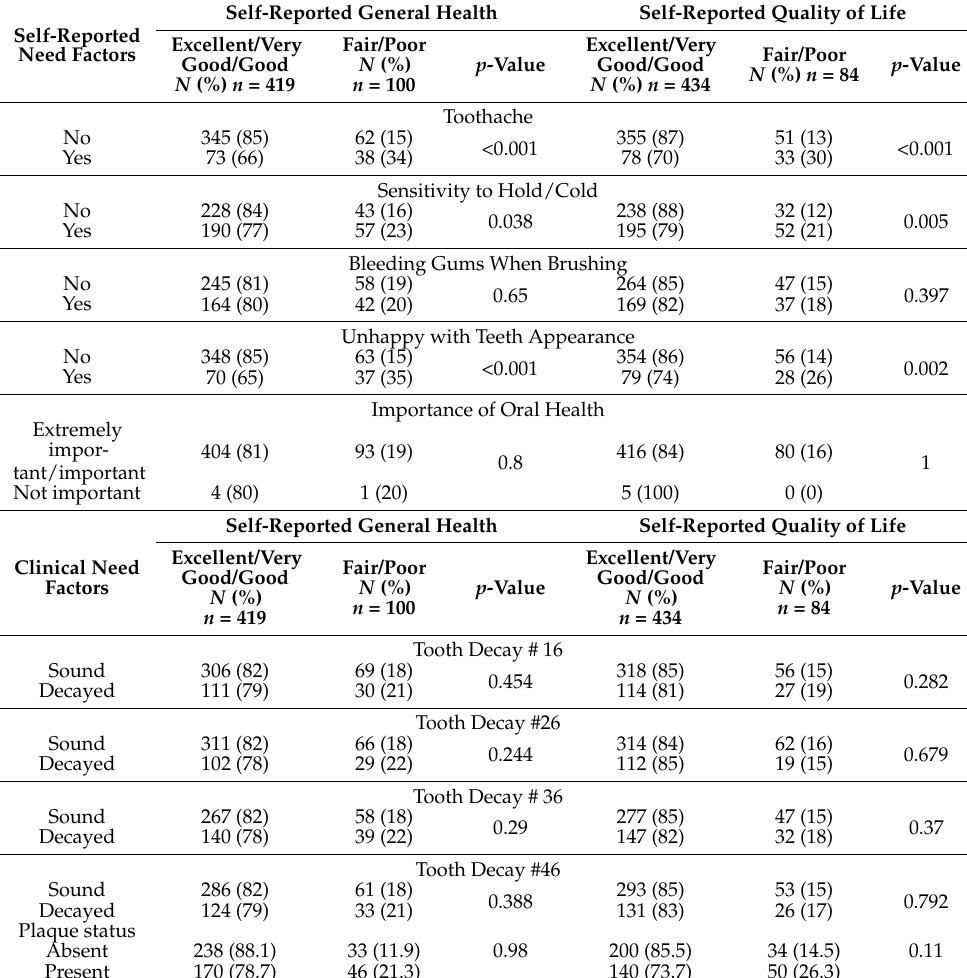
Table 4. Frequency distribution of the A&N need factors between self-reported general health and self-reported quality of